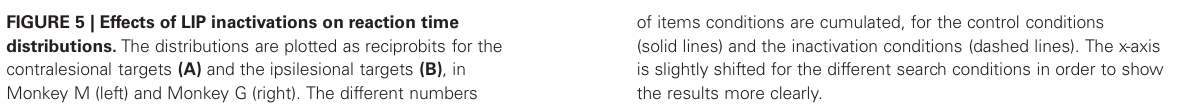
of items conditions are cumulated, for the control conditions (solid lines) and the inactivation conditions (dashed lines). The x-axis is slightly shifted for the different search conditions in order to show the results more